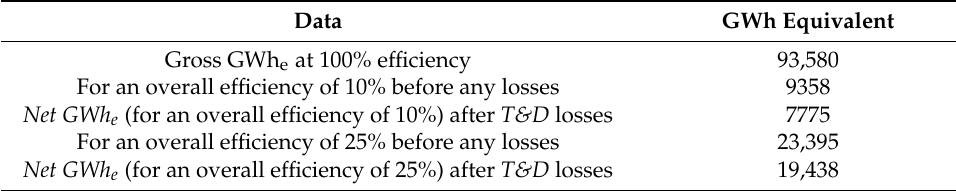
Table 6. Summary of the electrical generation potential using agricultural